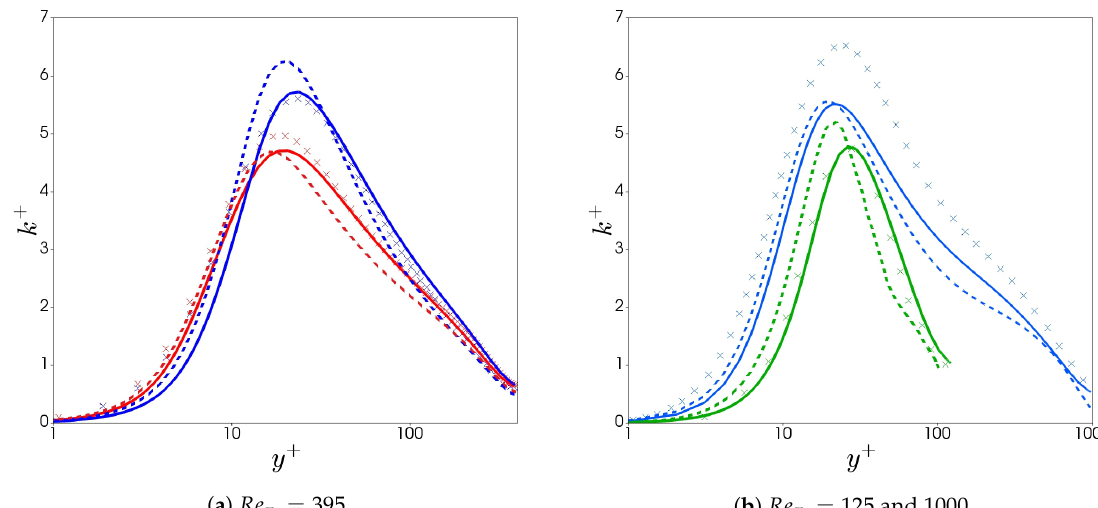
Figure 4. Comparison of turbulent kinetic energy between DNS data ( × crosses) and predictions with the new model (continuum lines), and previous model (dash lines): ( a ) Re τ 16)—and blue (IDR case 19); ( b ) Re τ